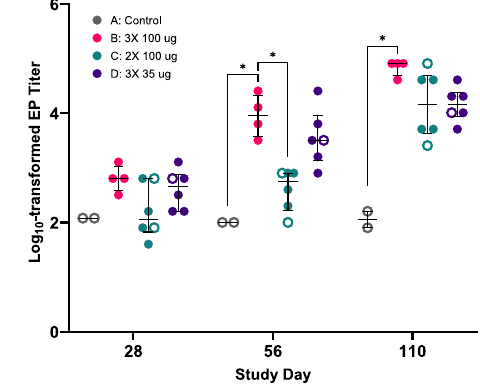
Fig. 1 Kinetics of RT-speci fi c endpoint titers following vaccina- tion. Vaccinated macaques and control animals had serum samples are shown with central dashed lines representing the groups ’ median values, and the dotted lines representing the 1st and 3rd quartiles. Statistical signi fi cance between the experimental groups is shown with asterisks (* p < 0.05, ** p < 0.01), as determined by Kruskal-Wallis tests followed by Dunn ’ s multiple comparisons tests. Filled circles represent survivors while open circles represents